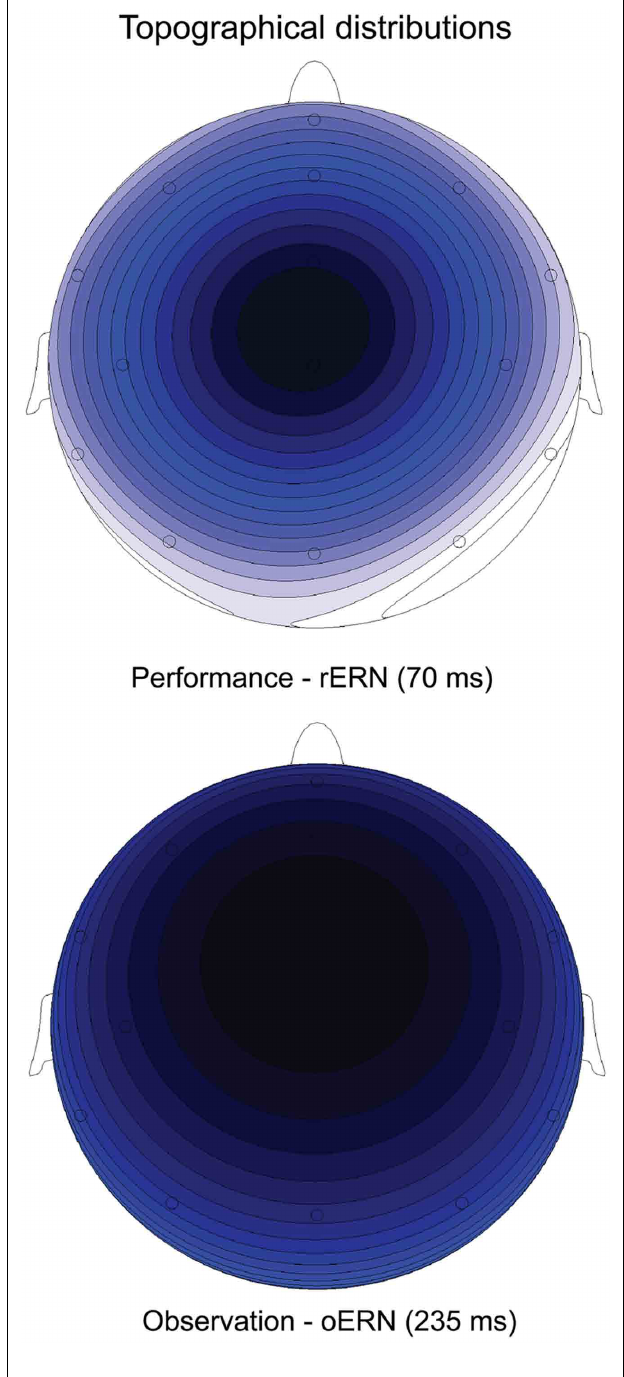
FIGURE 3 |Topographical distribution of the difference waves (incorrect minus correct) showing the expected frontocentral distribution for the rERN at peak onset (70ms) in the Performance condition (upper panel) and for the oERN at peak onset (235ms) in the Observation condition (lower panel). Darker colors indicate more negative